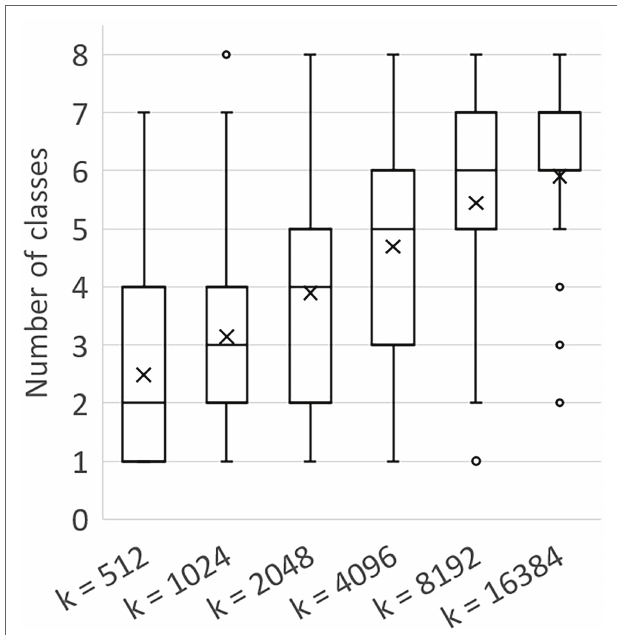
FIGURE 7 | Boxplot showing the number of classes per chunk for different values of k , based on the training sets created using a = 100. The mean values are shown as “x.” The box shows the lower and upper quartile, the whiskers indicate the highest and lowest number of classes per chunk within 1.5 times the inter-quartile range. Values outside this range were considered outliers and are shown as a